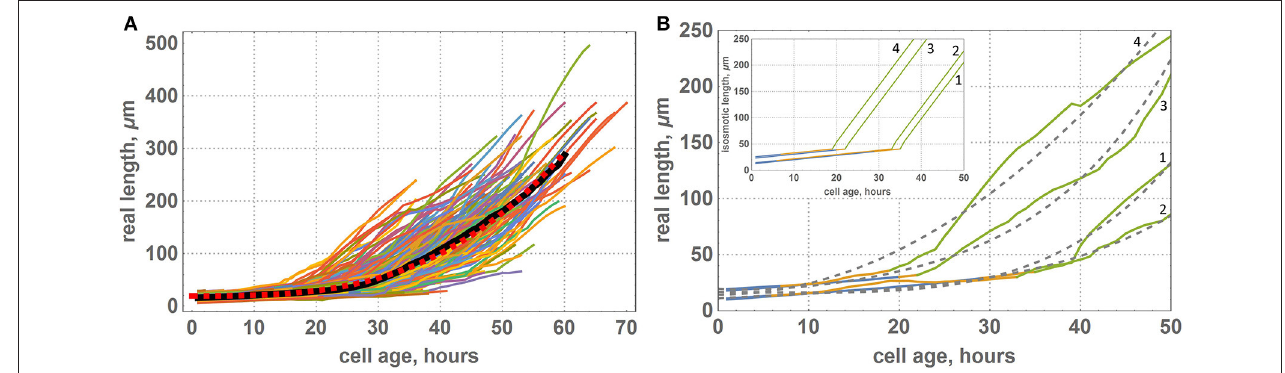
FIGURE 6 | Growth functions of visible lengths for cells of the “model leaf” within symplastic growth mode. (A) Growth functions of visible lengths for all cells of the leaf, where the black curve denote the average lengths of cells of the same age and red dashed curve denotes a smooth function approximation [ f ( x ) = 19.3119 + 0.0013 x 3 ]. (B) Growth functions of visible lengths for some selected cells of the leaf: 1st cell had a small initial length and appeared at the proximal part of the DZ, 2nd cell had a small initial length and appeared at the distal part of the DZ, 3rd cell had a large initial length and appeared at the proximal part of the DZ, and 4th cell had a large initial length and appeared at the distal part of DZ. The color of the curve denotes the growth zone: blue is for the DZ, yellow is for transition zone, and green is for the EZ. Gray dashed curves denote a smooth approximation with a polynomial function. The inset shows the corresponding growth functions for isosmotic